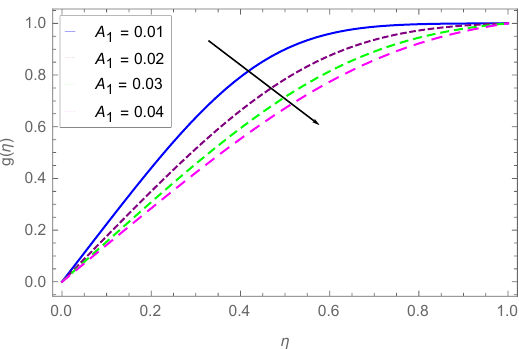
Figure 17. Plot depicting θ ( η ) dependence on A 1 . The variation in the thermal boundary layer for various values of the nanoparticle volume fraction is portrayed in Figure 18. As we have stated earlier, the larger values of the nanoparticle concentration decrease the boundary layer thickness. That is why the larger values of the nanoparticles increase the temperature profile. The variation in the thermal boundary layer is larger at η = 0.56, when the nanoparticle volume fraction values increase from 0.01 to 0.04.